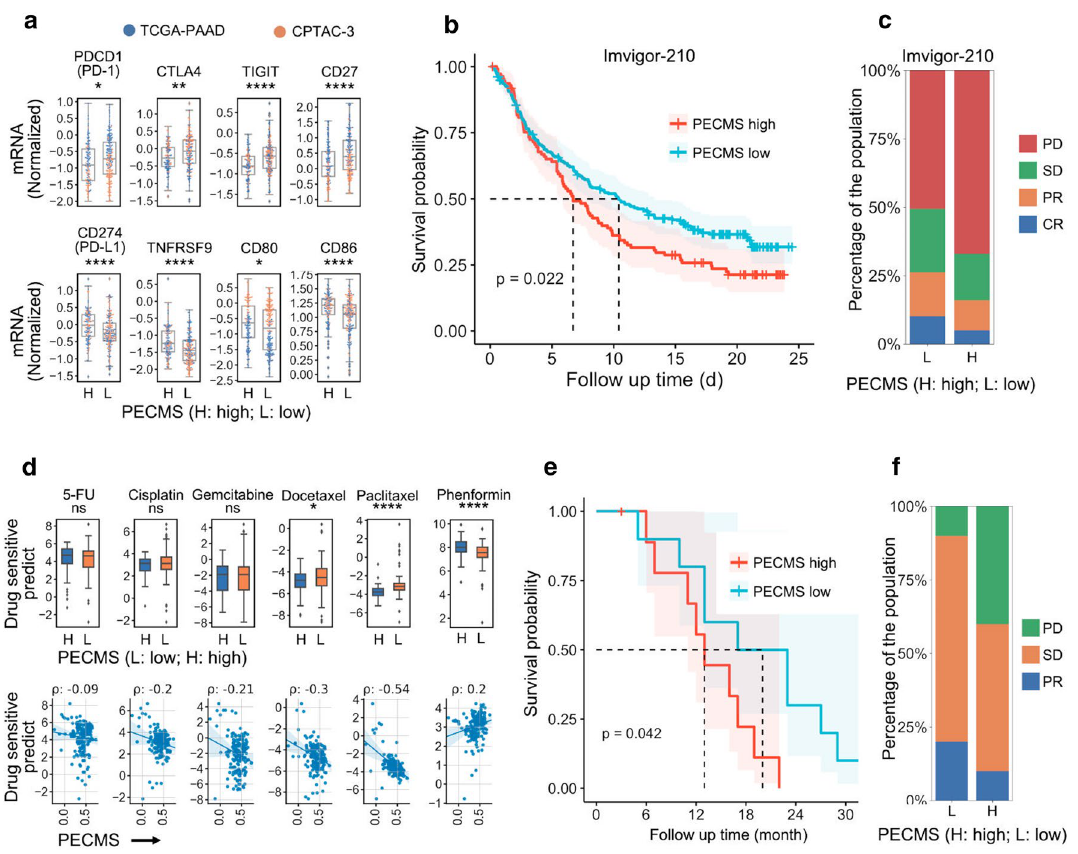
Fig. 4 Relationship between PECMS and prediction of drug sensitivity ( a The normalized mRNA expression of immune-privileged and ICB- sensitive biomarkers. b Survival of PECMS-high and PECMS-low patients in IMvigor-210. c Response of PECMS-high and PECMS-low patients in IMvigor-210. d Drug sensitivity prediction of chemotherapy drugs in different PECMS groups (L: PECMS-low; H: PECMS-high) and correla- tion between PECMS and drug sensitivity prediction. e Survival curves of different PECMS groups in our single-center retrospective cohort. f Response to chemotherapy in different PECMS groups in our single-center retrospective cohort. ns: no significant difference; *: P < 0.05; **: P < 0.005; ***: P < 0.0005; ****: P <